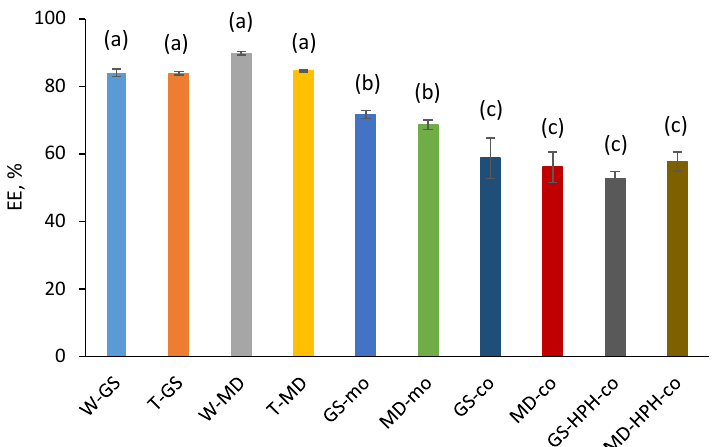
Figure 4. Encapsulation efficiency (EE) levels of the fish-oil-loaded capsules produced via spray- drying or electrospraying (monoaxial and coaxial). Samples followed by a letter (a–c) indicate statistical differences ( p ≤ 0.05) between